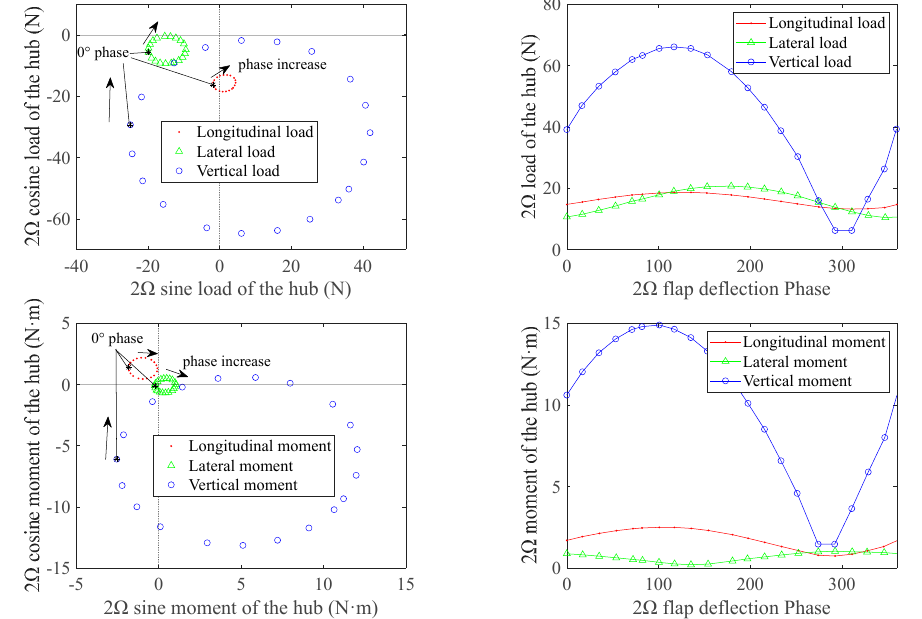
Figure 6. The effect of change in the higher-order flap phase on the vibration load and moment of the